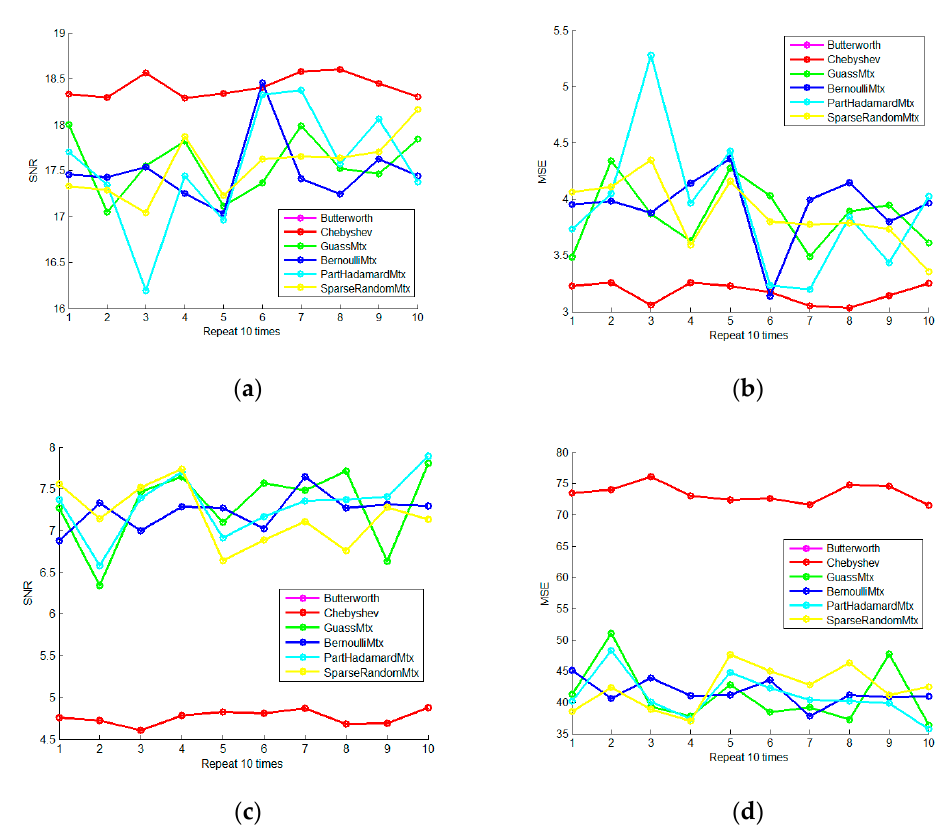
Figure 10. The Repeated Denoising Experiment ( a ) is the 10-times repetitive SNR curve of IIR filtering and BPDN compressive sensing denoising methods based on four sampling matrices when sigma is 2; ( b ) is the 10-times repetitive MSE curve of the denoising methods when sigma is 2; ( c ) is the 10-times repetitive SNR curve of the denoising methods when sigma is 10; ( d ) is the 10-times repetitive MSE curve of the denoising methods when sigma is 10.